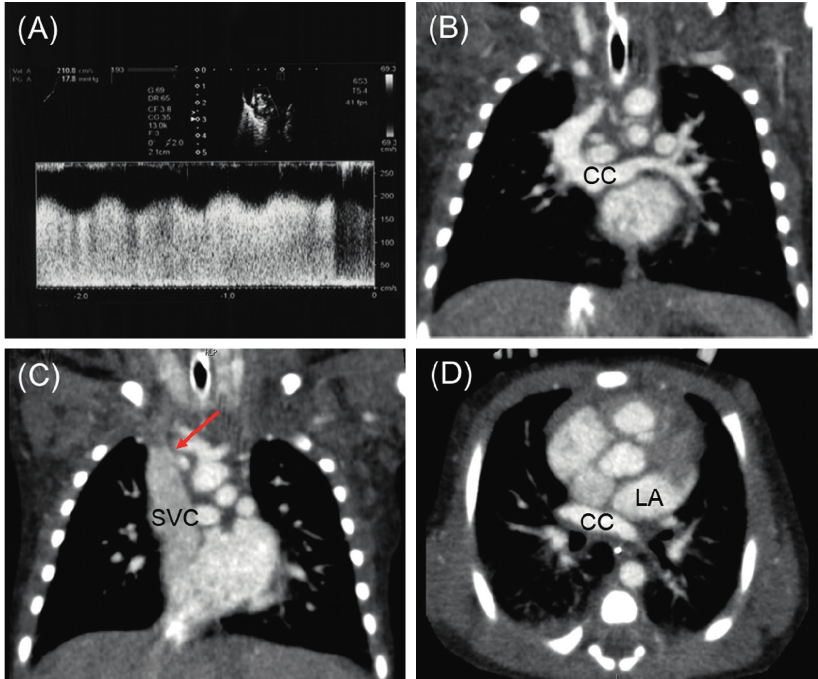
Figure 2: Various tests after birth. (A) Echocardiography displays a continuous flow pattern at the confluence of the pulmonary vein common chamber with the superior vena cava. (B) Contrast-enhanced computed tomography reveals bilateral pulmonary veins flowing into the common chamber. (C) The red arrow indicates severe stenosis of the confluence of the pulmonary vein common chamber with the superior vena cava. (D) The common chamber did not connect with the left